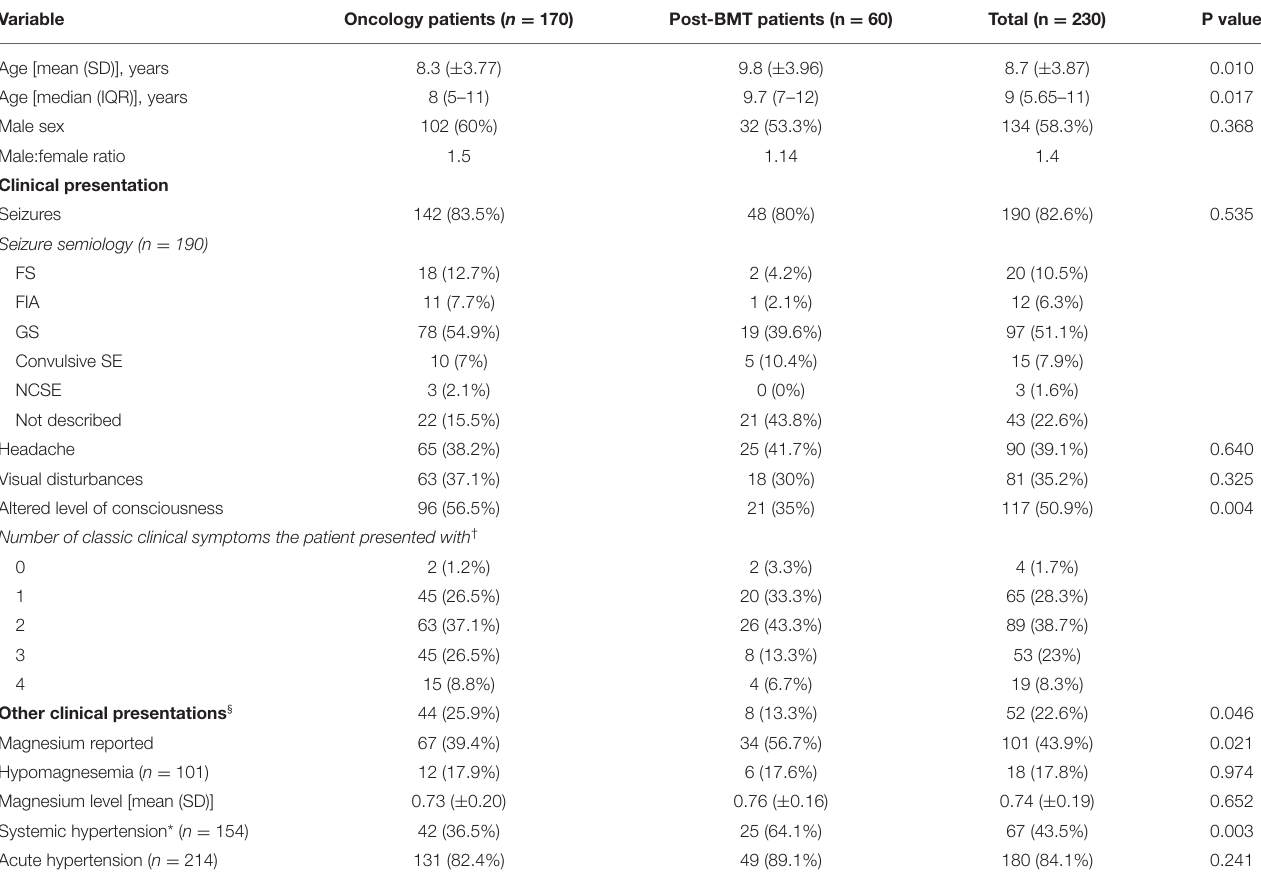
TABLE 1 | Comparison of demographics and clinical presentation of PRES between oncology and post-BMT patients. Variable Oncology patients ( n = 170)